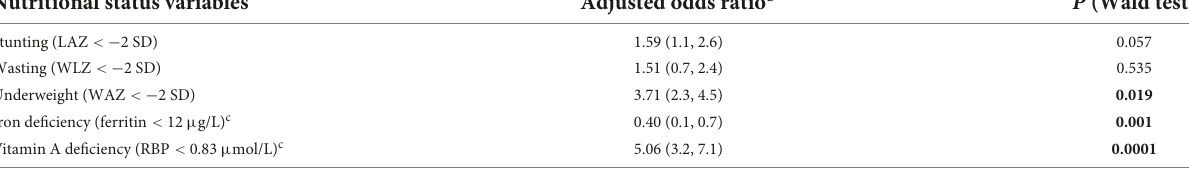
TABLE 5 Multivariate analysis a of odds for inflammation marker (elevated CRP and AGP) association with infant nutritional status in the COVA